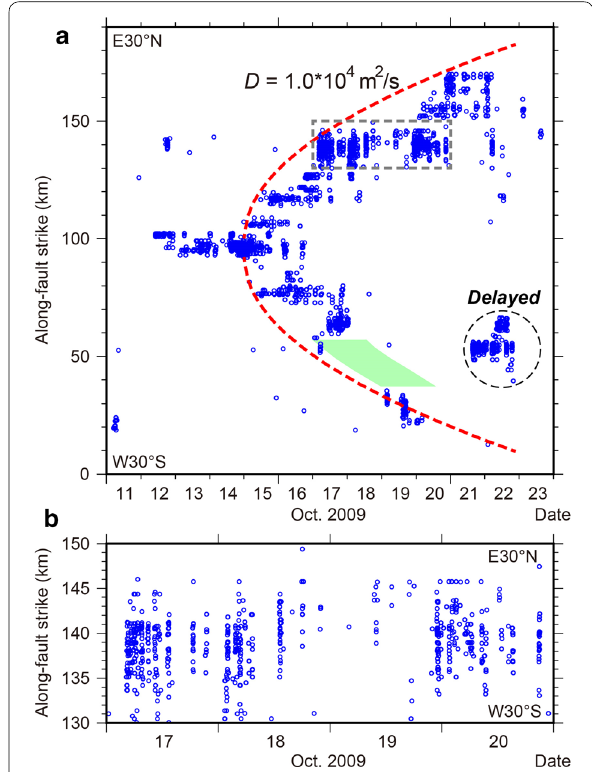
Fig. 4 An example of slow bilateral migration of LFEs during an ETS episode. a Space–time diagram of detected LFEs as a function of distance along fault strike. The green shaded area denotes a gap in LFEs along the migrating front. The gray dotted-line rectangle represents the boxed area enlarged in b . Other symbols and meanings are the same as in Fig. 3. b A zoomed-in view of the boxed area in